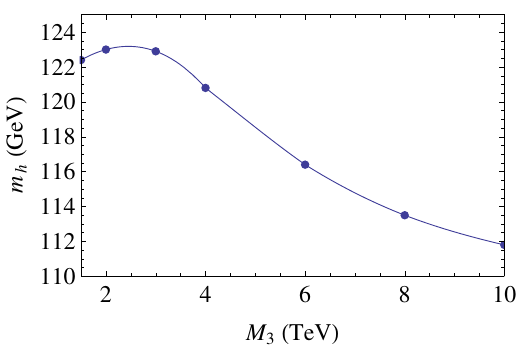
Figure 1 . Higgs mass dependence on the gluino mass parameter M 3 for m ~ 459 GeV, and sin (cid:18) t = 0 : 724, as calculated with SUSY-HIT